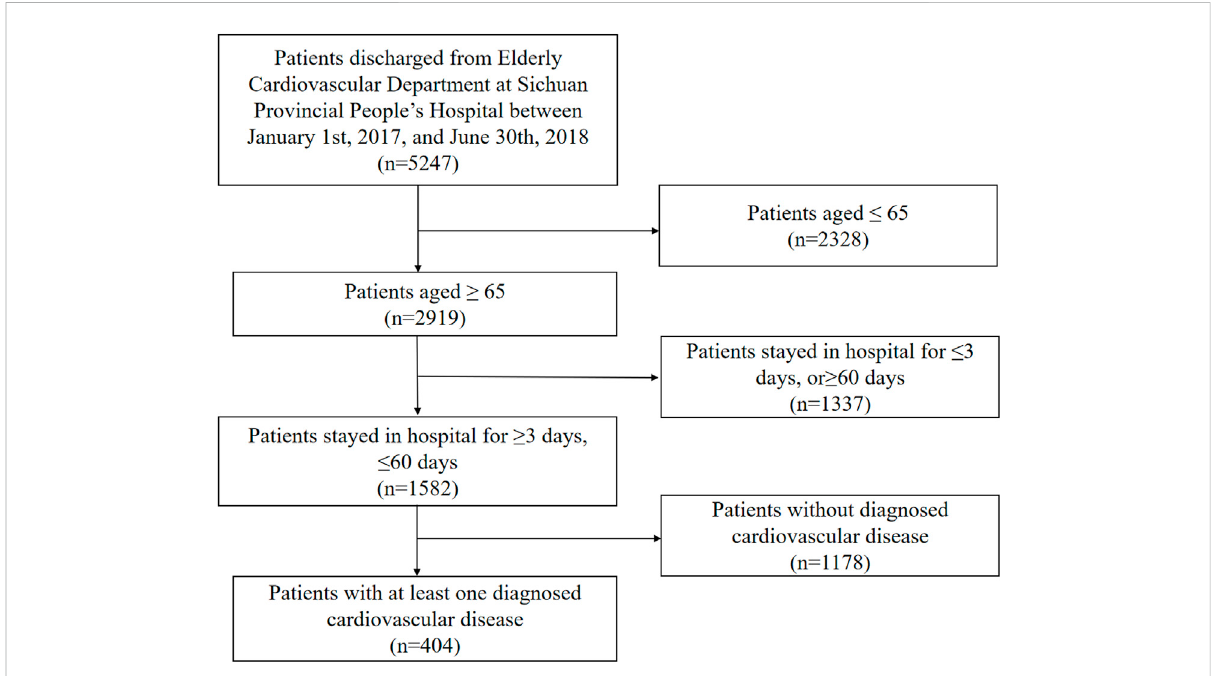
FIGURE 1 Flowchart of patient